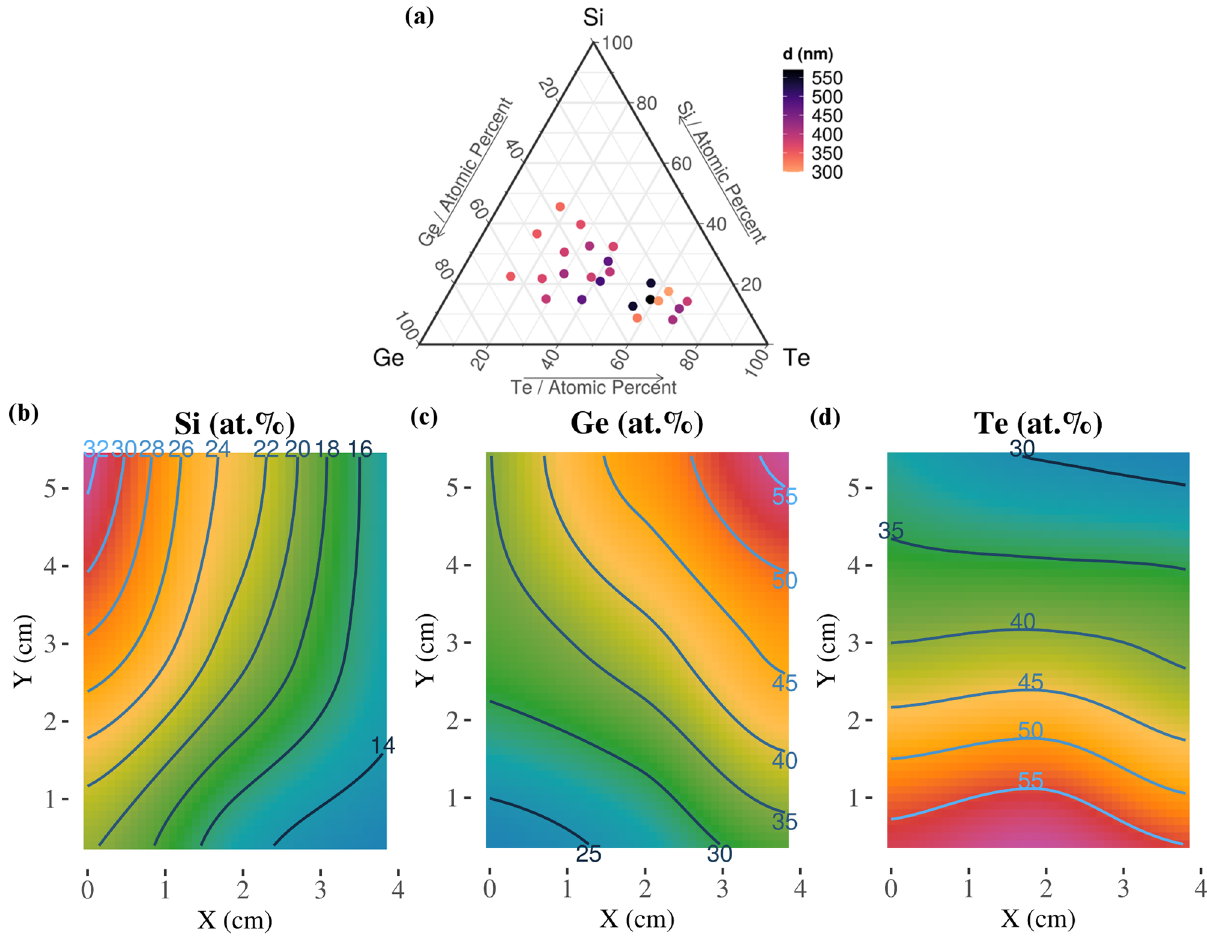
Figure 1. The chemical composition and thickness of the combinatorial chalcogenide library. ( a ) Thickness ( d ) distribution (measured by spectroscopic ellipsometry) in the center of the 24 samples; Elemental concentration gradient in one representative deposition for ( b ) Si; ( c ) Ge; ( d ) Te. The ternary diagram in ( a ) was generated with the R software [v. 3.6.3] (R: A language and environment for statistical computing, R Core Team, R Foundation for Statistical Computing, Vienna, Austria (2020) http:// www.R- proje ct. org/.) using the package ggtern [v. 3.3.0] (https:// cran.r- proje ct. org/ web/ packa ges/ ggtern/ index.